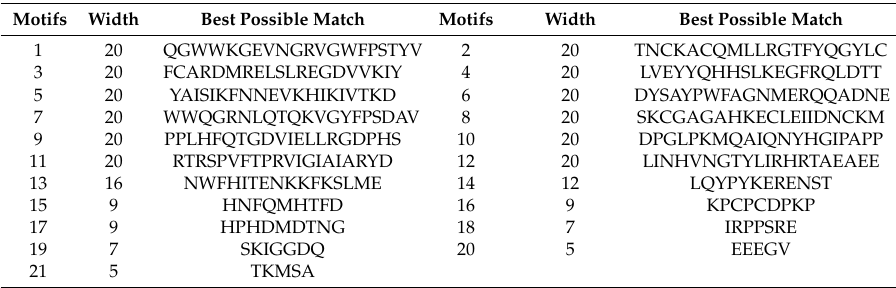
Table 1. Conserved motifs discovered between Vav3 and Vav2 molecules from different species using the MEME